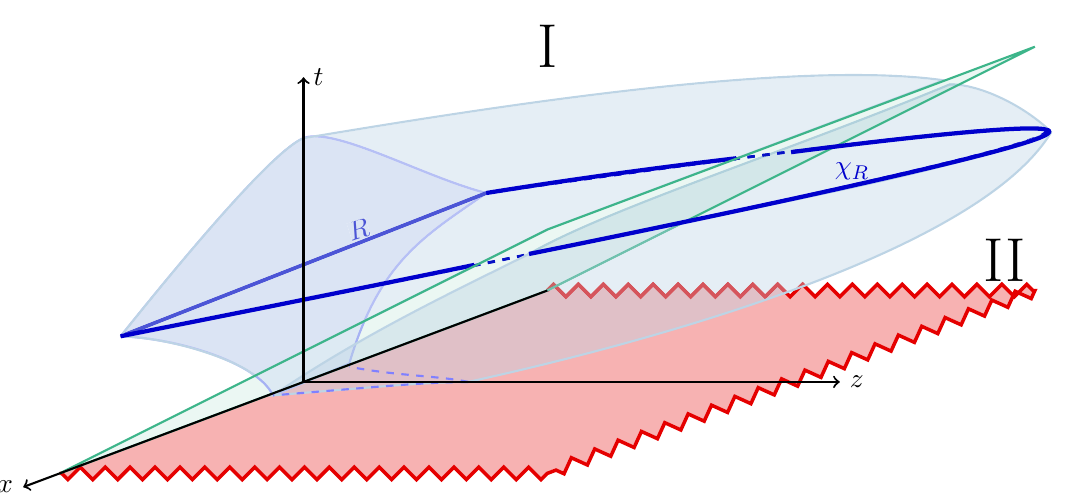
Figure 8 . The entanglement wedge EW region R in the contracting branch ( p < 0) probes region II. Its boundary causal domain D incomplete, and so is the entanglement wedge EW